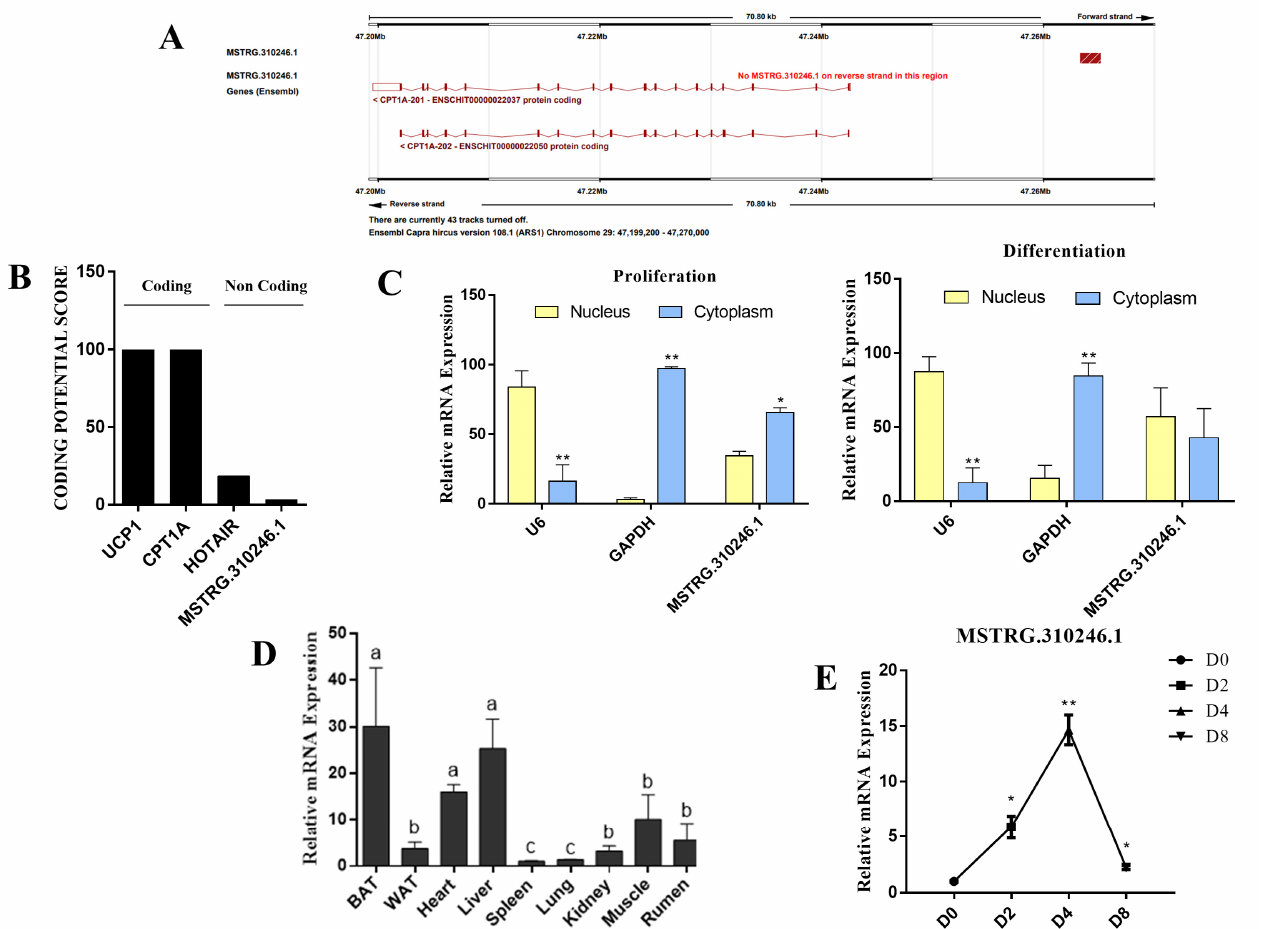
Figure 1. Identification and characterization of MSTRG.310246.1 in goats. ( A ) Position of MSTRG.310246.1 on the goat genome. ( B ) Coding ability prediction of MSTRG.310246.1. ( C ) Nuclear and cytoplasmic localization results showed that MSTRG.310246.1 was localized in both the nuclear and cytoplasmic compartment in the proliferation and differentiation stages of brown adipocytes. ( D ) The expression of MSTRG.310246.1 in BAT, WAT, heart, liver, spleen, lung, kidney, muscle, and rumen of goats. Error bars represent SEM of six biological replicates, n = 6. The different letters (a,b,c) in the histogram revealed that MSTRG.310246.1 expressed significantly different among each other ( p < 0.05). ( E ) The expression level of MSTRG.310246.1 in different differentiation stages of goat brown adipocytes. Error bars represent SEM of six biological replicates, n = 6, * p < 0.05, ** p < 0.01 relative to D0